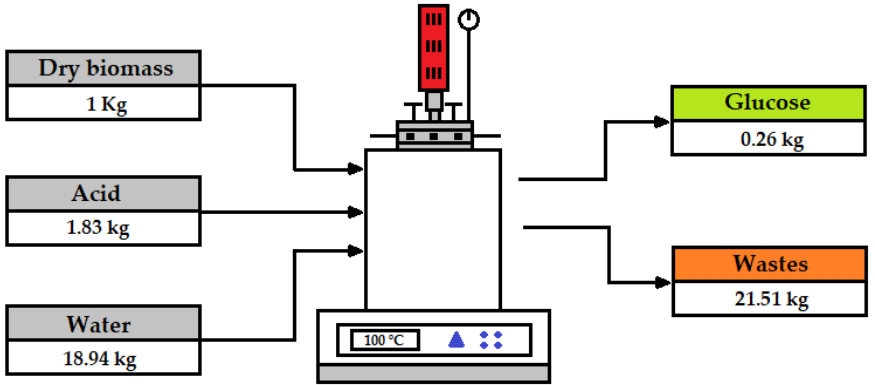
Figure 6. Matter balance of the hydrolysis reaction.